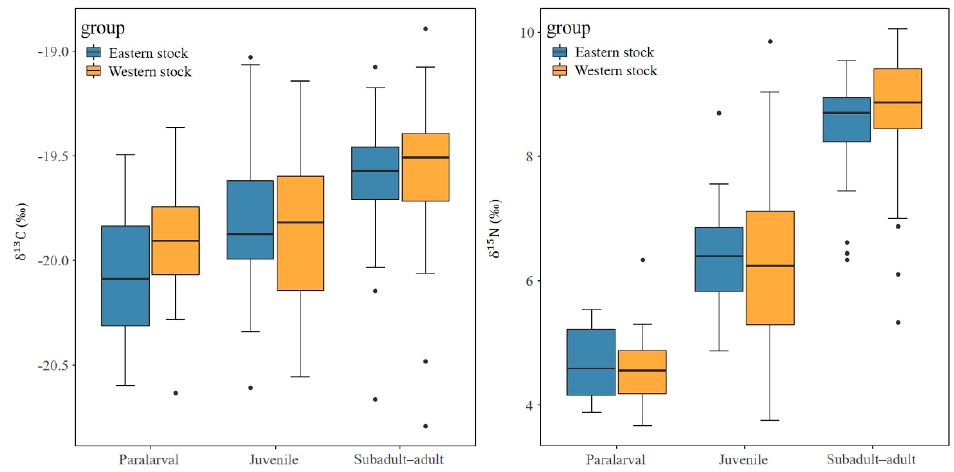
Figure 6. Box–whisker plot of δ 13 C and δ 15 N values for O. bartramii eye lenses at different ontogenetic stages. The boxes cover the range from the first to the third quartiles, and the whiskers correspond to the highest and lowest values. The bars in bold mark the median values. Black dot represents outliers. Table 4. Stable isotope concentrations of neon flying squid eye lenses from the eastern and western stock populations (multiple comparisons by letters (a,b) to show significant differences ( p < 0.05). SD represents standard deviation). (4.56‰ ± 0.64‰), 3.76‰ to 9.85‰ (6.33‰ ± 1.39‰) and 5.33‰ to 10.06‰ (8.80‰ ± 0.82‰), respectively. The results of ANOVA showed significant differences in δ 13 C and δ 15 N values of different growth stages ( F C = 43.769, p C < 0.05; F N = 102.968, p N < 0.05) (Figure 6; Table